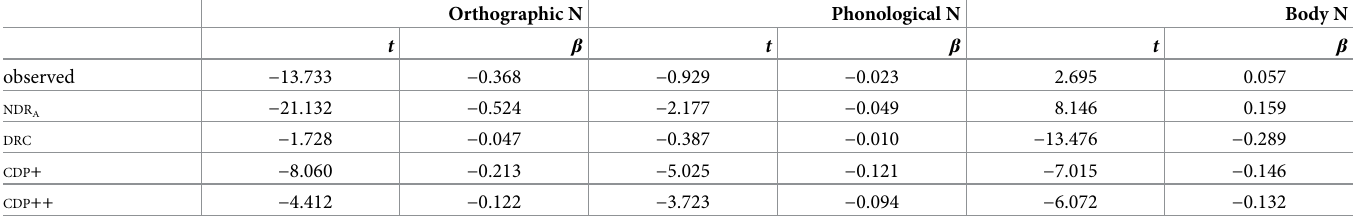
Table 1. The linear interplay of orthographic, phonological and body neighborhood density. Listed are t -values and β coefficients for each of the predictors in an addi- tive linear